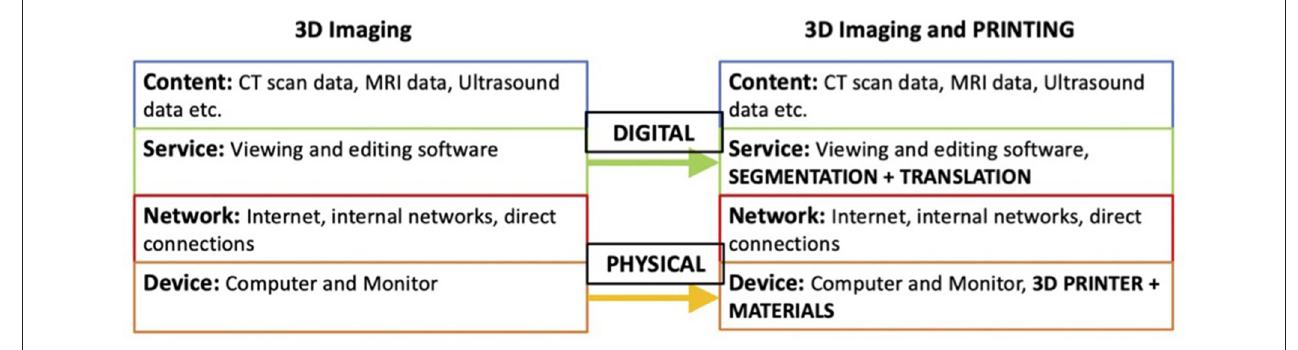
FIGURE 2 | Innovation in the service and device layers of 3D Imaging’s layered modular